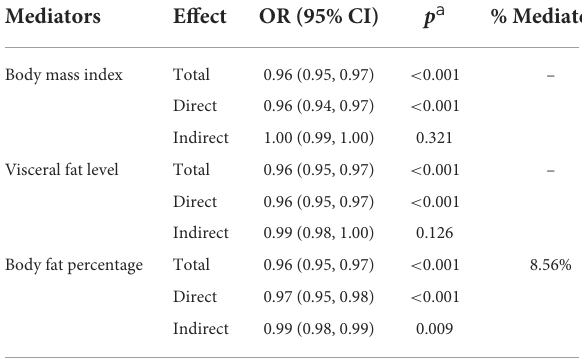
TABLE 3 Body mass index, body fat percentage, and visceral fat level as mediators in the association between health literacy and hypertension ( n =